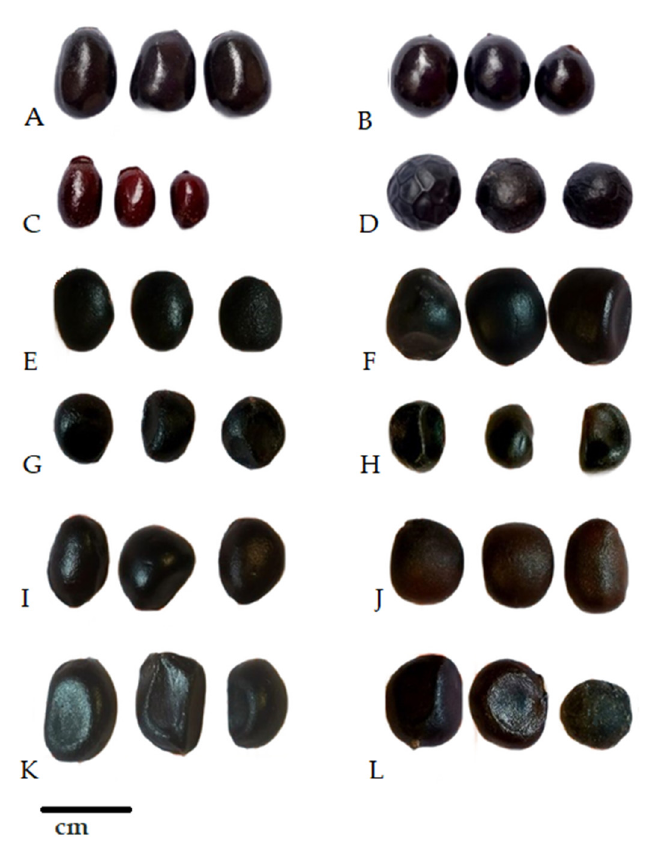
Figure 2. Ripe seeds of several herbaceous peony species (seed collection, 2021); ( A ) P. peregrina , ( B ) P. banatica , ( C ) P. tenuifolia , ( D ) P. daurica , ( E ) P. veitchii , ( F ) P. mairei , ( G ) P. emodi , ( H ) P. anomala , ( I ) P. sterniana , ( J ) P. obovata , ( K ) P. lactiflora , and ( L ) P. sinjiangensis. Species of herbaceous peonies differ in the number, size, and shape of their seed follicles which, in turn, affect the number and size of seeds [38,46]. They also differ in